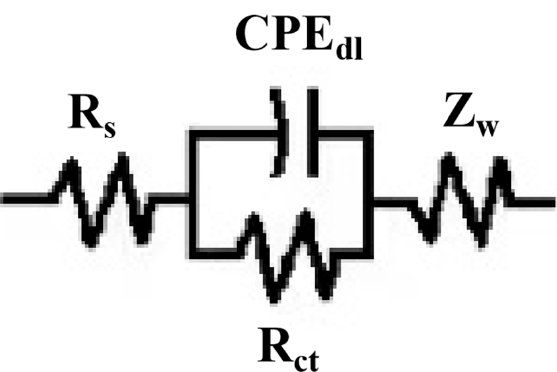
Figure 10. Best-fit circuit diagram for Ni-Cu-P-PTFE composite plating of Q235B mild steel and different PTFE concentrations. Table 3. Impedance values of the best-fit circuit for Q235B mild steel and Ni-Cu-P-PTFE composite plating with different PTFE concentrations.